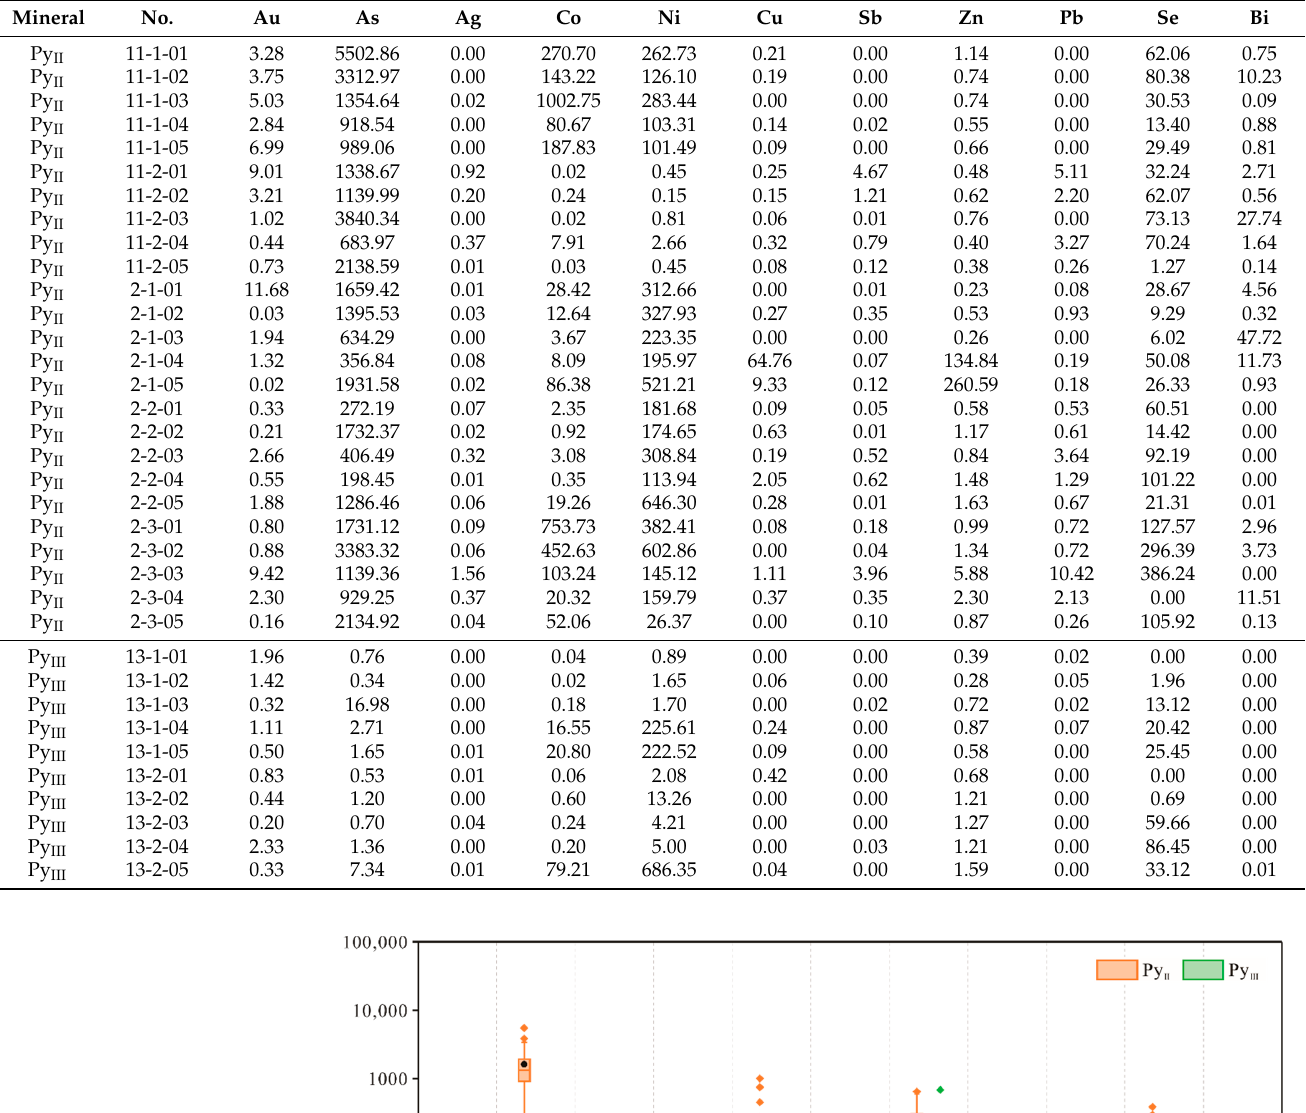
Table 1. Trace elements (ppm) in different types of pyrite from the Shuangwang gold deposit. Mineral